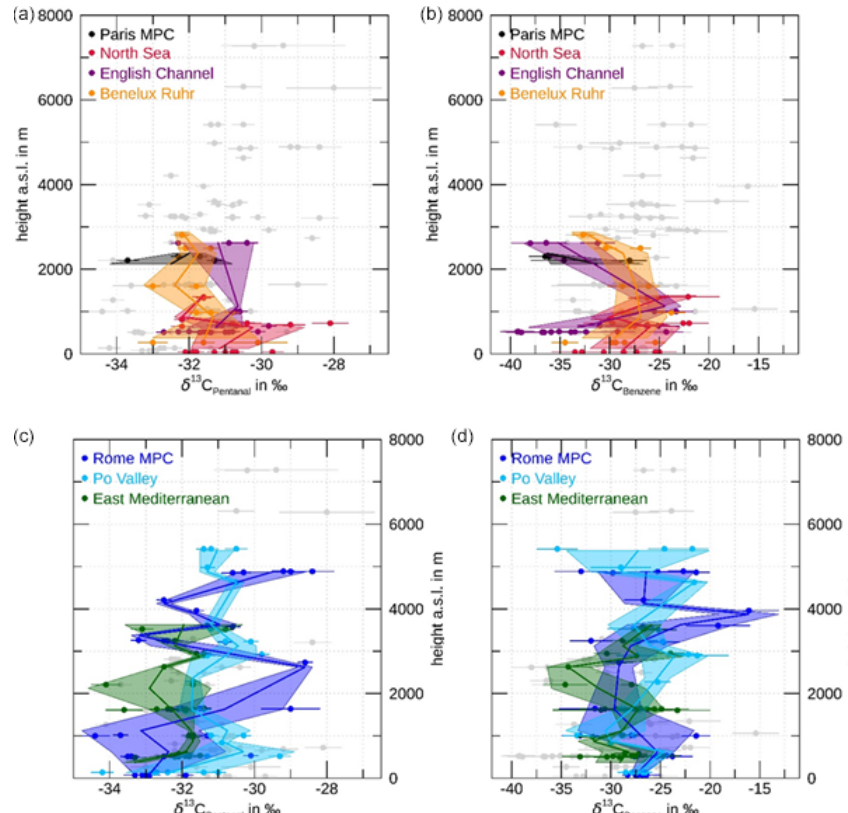
Figure 19. Vertical distribution of δ 13 C values in C 5 H 10 O ( a, c ) and C 6 H 6 ( b, d ) in whole air samples taken on HALO and at the ground sites in London, Wuppertal, Milan, and Rome. Data for northbound flights ( a–b ) are colour coded for Paris MPC (black), the North Sea (red), the English Channel (violet), and BNL/Ruhr (orange). Data for southbound flights ( c–d ) are colour coded for Rome MPC (blue), Po Valley MPC (cyan), and Eastern Mediterranean (green). The coloured shadings refer to the standard deviation of δ 13 C values in altitude bins of 250m. Mean δ 13 C values of the respective altitude bins are represented as solid colour-coded lines. The δ 13 C values at the lowest altitudes in each colour represent the results of air samples at the ground stations: London (red), Wuppertal (orange), Rome (blue), and Milan (cyan). Error bars in δ 13 C are given for each sample value. Remaining data are shown in